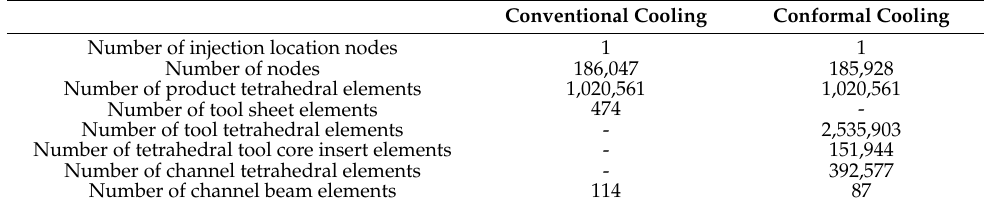
Table 1. Comparison of mesh models for conventional and conformal